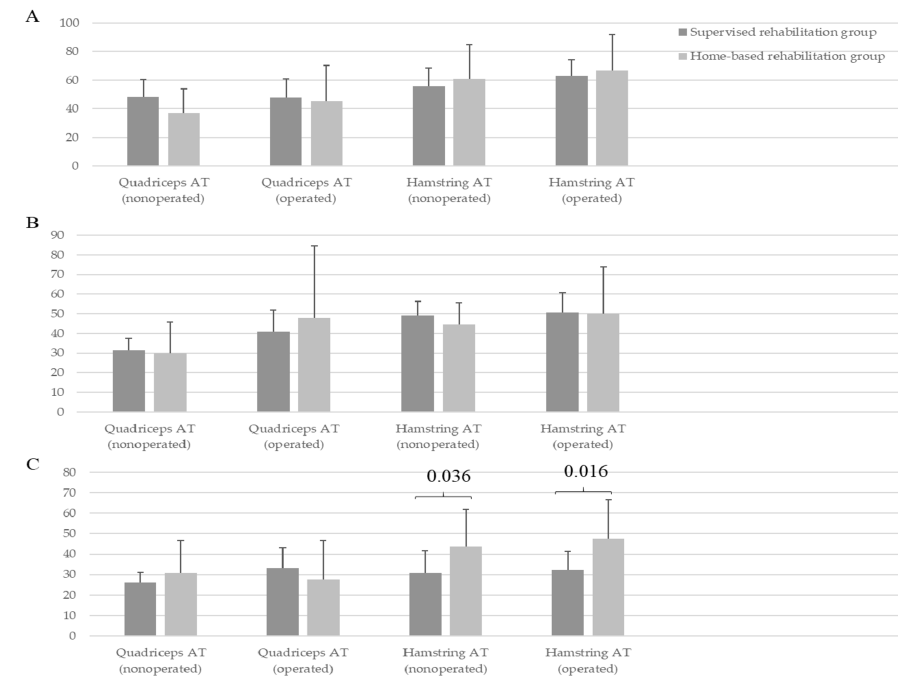
Figure 2. Comparison of acceleration time (AT) of quadriceps and hamstring in operative and nonoperative knees between the supervised rehabilitation group and home-based rehabilitation group. ( A ) Preoperative baseline, ( B ) At postoperative 6 months, and ( C ) At postoperative 1 year. Medicina 2021 , 57 , x FOR PEER REVIEW